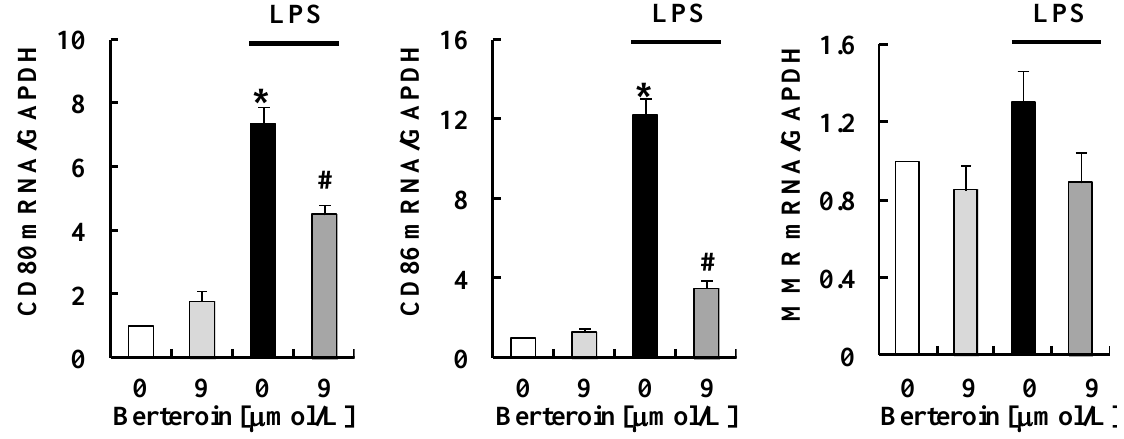
Figure 3. Berteroin decreases the transcripts of CD80 and CD86 in lipopolysaccharide (LPS)-stimulated Raw 264.7 cells. The cells were treated with 0 or 9 μmol/L berteroin and/or LPS as described in Figure 1. Total RNA was isolated and reverse-transcribed, and real-time PCR was performed. Each bar represents mean ± SEM ( n = 3). * Significantly different from the untreated control group (0 mg/L LPS + 0 μmol/L berteroin) ( p < 0.05). #